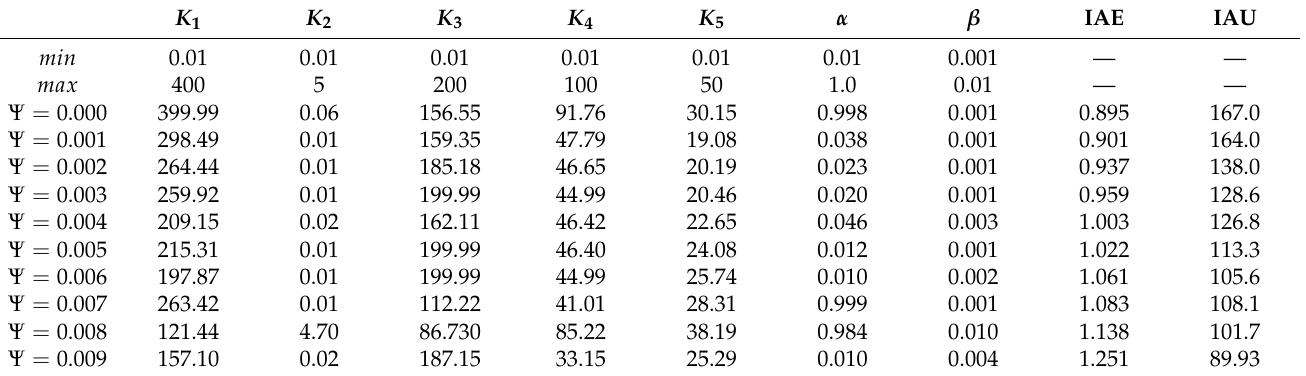
Table 5. Results of the tuning of the BELBIC-type altitude controller using the PSO algorithm ( Ψ = var , Γ =